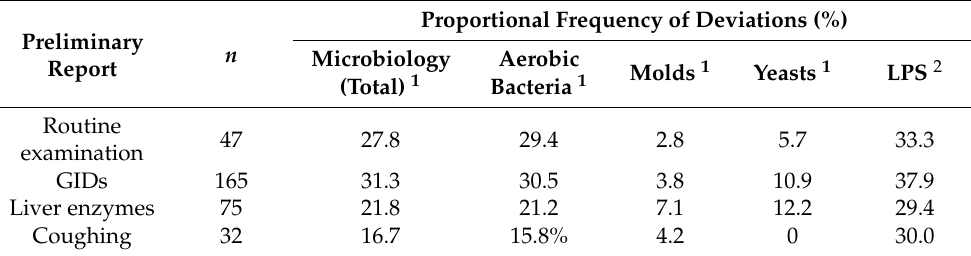
Table 5. Proportional frequency of deviations in microbiological quality (assessed using VDLUFA ori- entation values [14]) of concentrates with different preliminary records given for submitted samples.